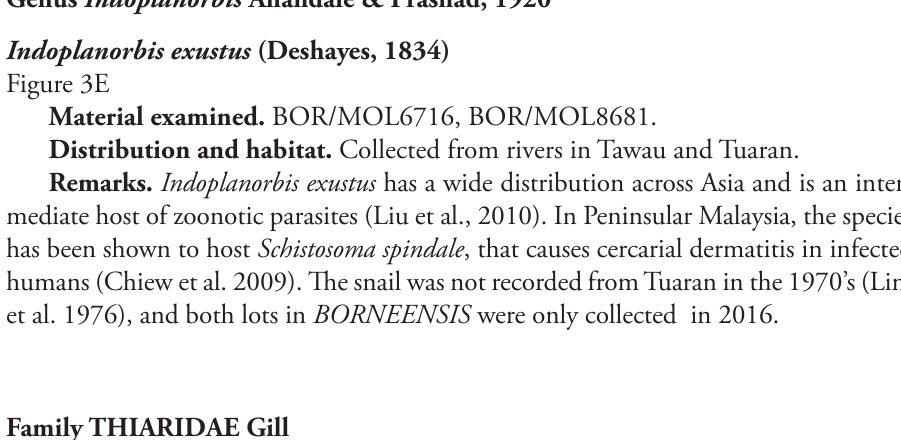
Material examined. BOR/MOL3451. Distribution and habitat. Single lot collected from Kiansom forest, 20km inland from Kota Kinabalu. Remarks. This species is native to North America and has been widely introduced to neighbouring Sarawak and Brunei, on Borneo (Ali 1993, Ng et al. 2015b). This ap- pears to be the first record of the species in Sabah.